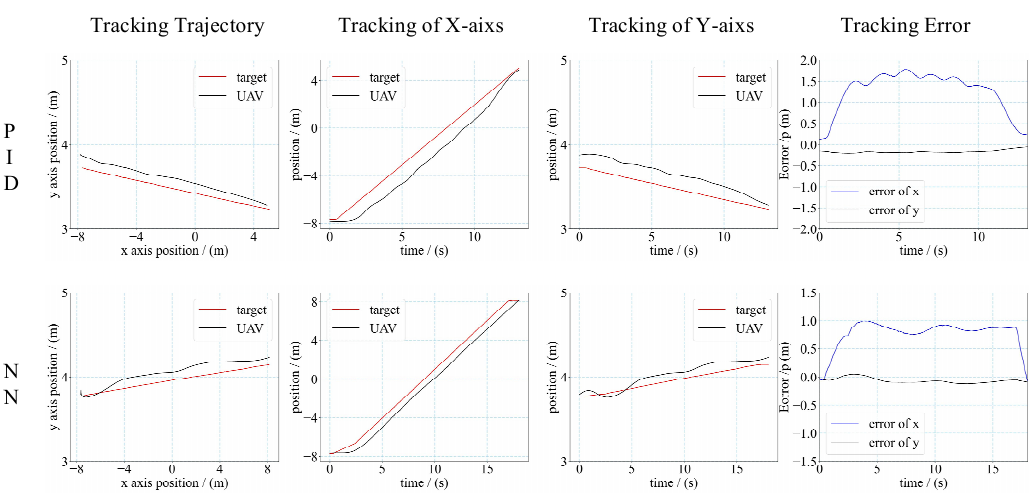
Figure 13. Trajectory and tracking error of UAV tracking target. (target’s velocity is 1.0 m/s).